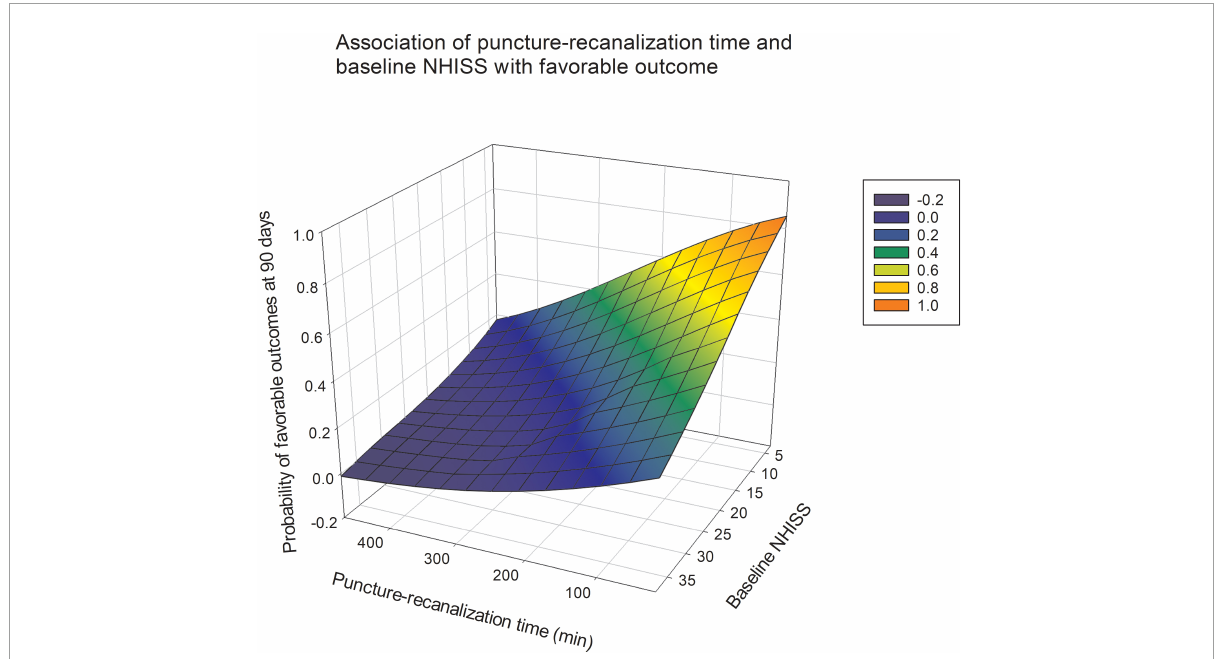
FIGURE3 The gray shading indicates 95% CIs. Association of NIHSS and time from puncture to recanalization with the probability of a favorable outcome at 90 days after endovascular